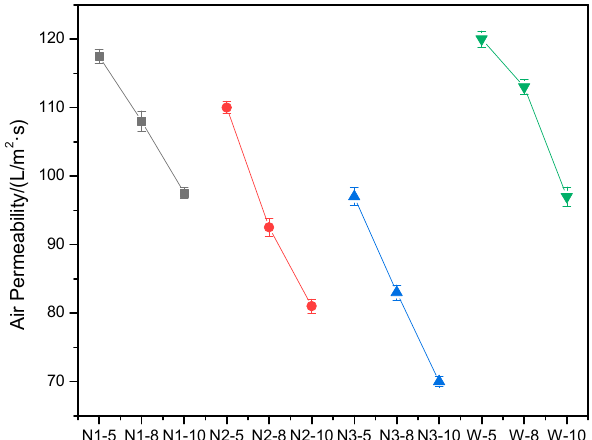
Figure 2. Air permeability results of waddings.